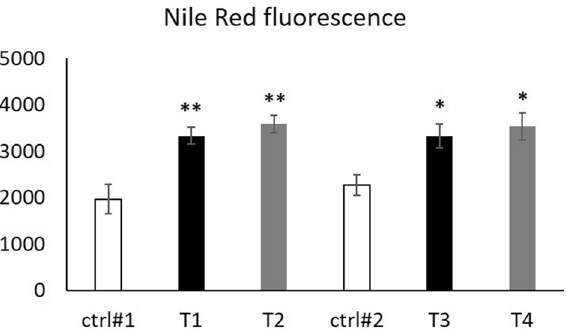
Figure 6. Nile red fluorescence in THP-1 cells incubated with SGBS-CM. THP-1 cells were incubated for 4 days with RPMI:SGBS-CM (1:1) from d4 [containing DMSO (T1) or DEHP (T2)] and d8 [previously treated with DMSO (T3) or DEHP (T4)] of adipogenesis. The corresponding controls were ctrl#1: RPMI + unconditioned induction medium from d4 (1:1) and ctrl#2: RPMI + unconditioned differentiation medium from d8 (1:1). To detect the intracellular lipid content of THP-1 macrophages on d7, the cells were stained with Nile red for fluorescence measurements. The data were statistically analyzed by Student’s t test. N = 4, n = 1 (4 pooled wells)